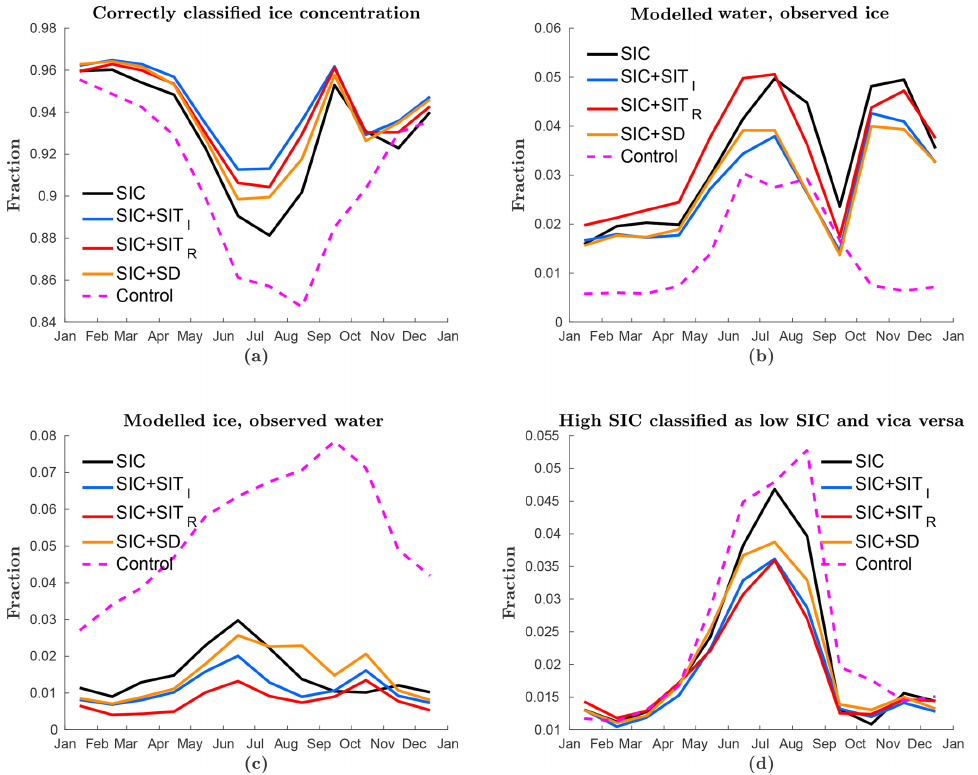
Figure 3. Classification of the model result based on three classes: high-concentration ice ( > 50%), low concentration ice ( < 50%) or water and compared to AMSR-E/2 SIC observations. The figures show (a) the fraction of correctly classified grid cells, (b) the fraction of grid cells with modelled ice while water is observed, (c) the fraction of grid cells with modelled water while ice is observed, and (d) fraction of grid cells where the model and observations have different SIC classification. The colour coding in the figure is the same as that of Fig. 2. These panels cover all possible classifications; thus the sum of them equals